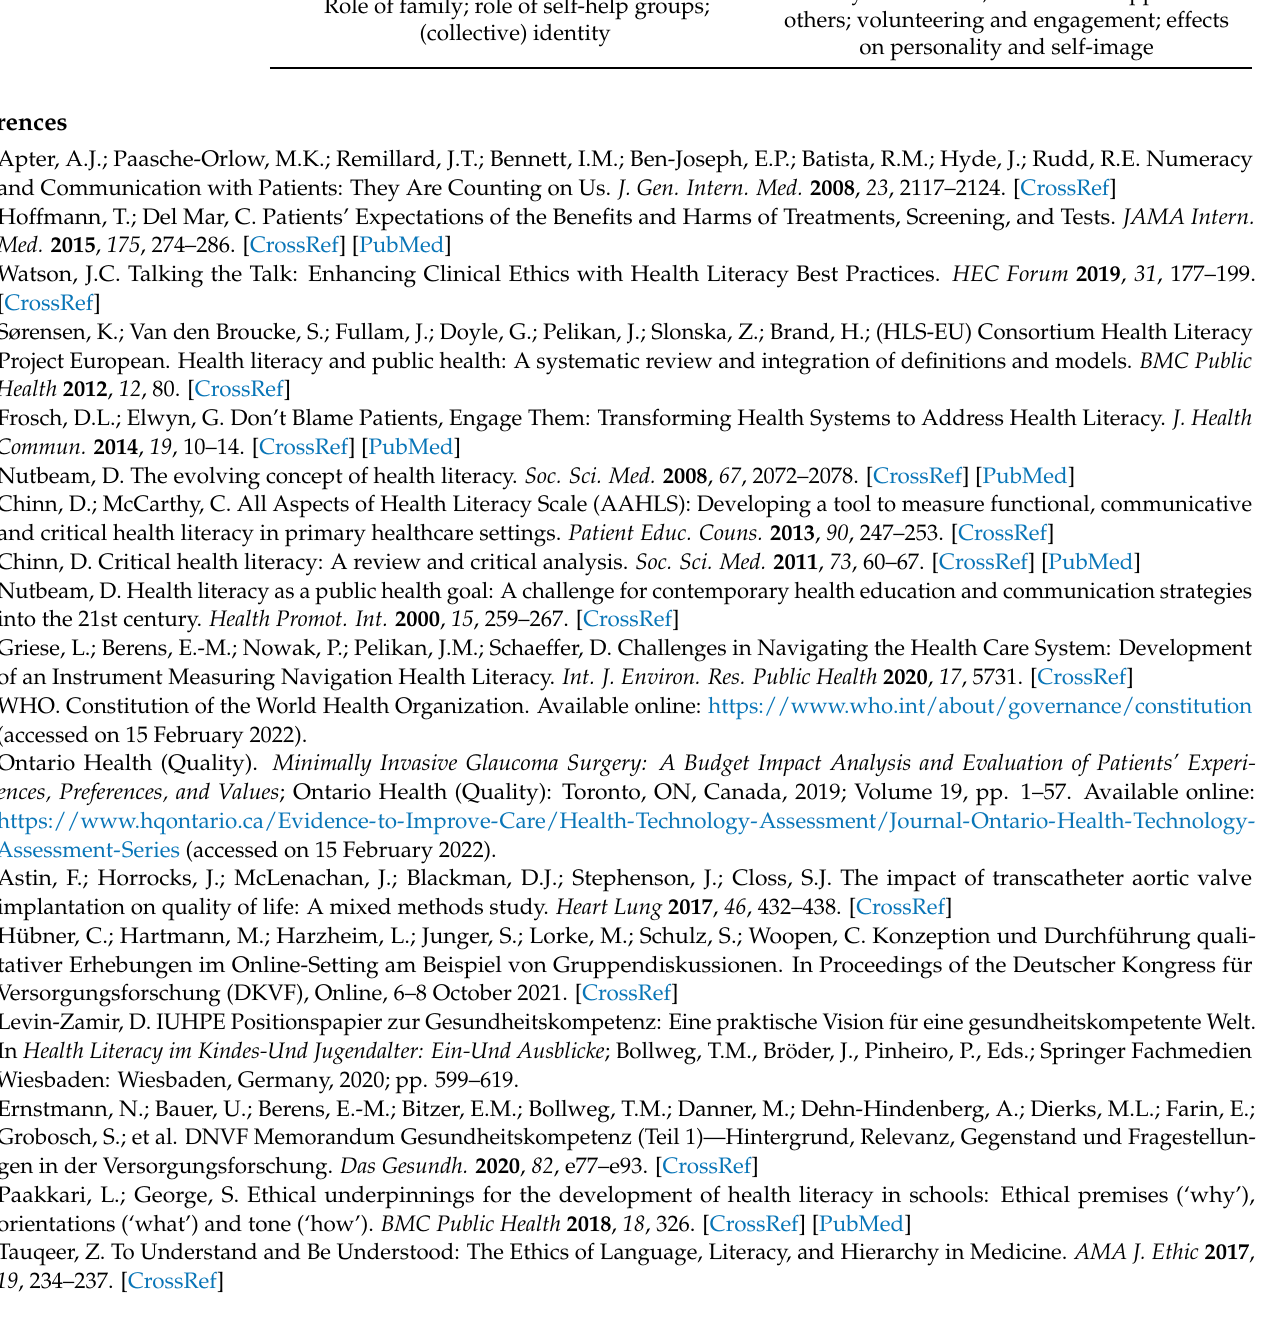
Table A3. Cont . Quality of care; treatment/implantation; Quality of care; additional treatments coordination of treatment and follow-up Attitudes, coping and responsibility Psychological coping; educating; respect for Coping strategies; anxiety and concerns own health COP: Implant related values Self-determination in the context of treatment irreversibility and perceptions of good life Quality of life; gratitude Attitudes towards the implant Identity and participation Family and friends; burden vs. support for Role of family; role of self-help groups; others; volunteering and engagement; effects (collective) identity on personality and